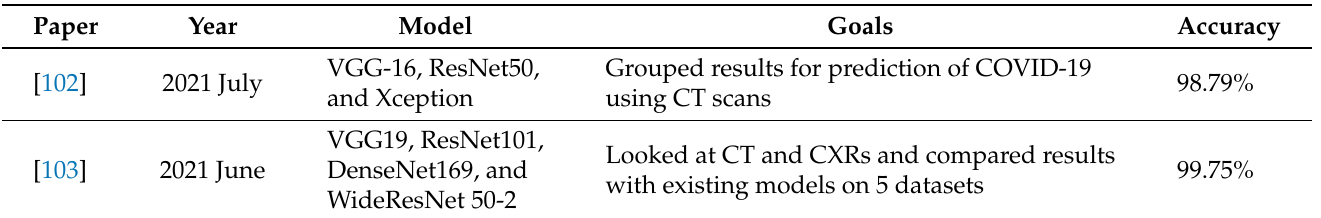
Table 4. Machine learning approach summarized using other datasets and ensemble